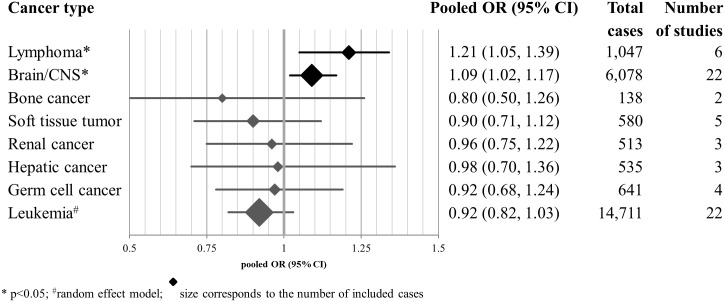
Pooled estimates of meta-analyses for eight studied cancer types.Lymphoma and brain cancers were associated with smoking during pregnancy at 95% confidence level. Random effects model was applied for leukemia only (see Tables A-K in S1 File for additional information by cancer type).